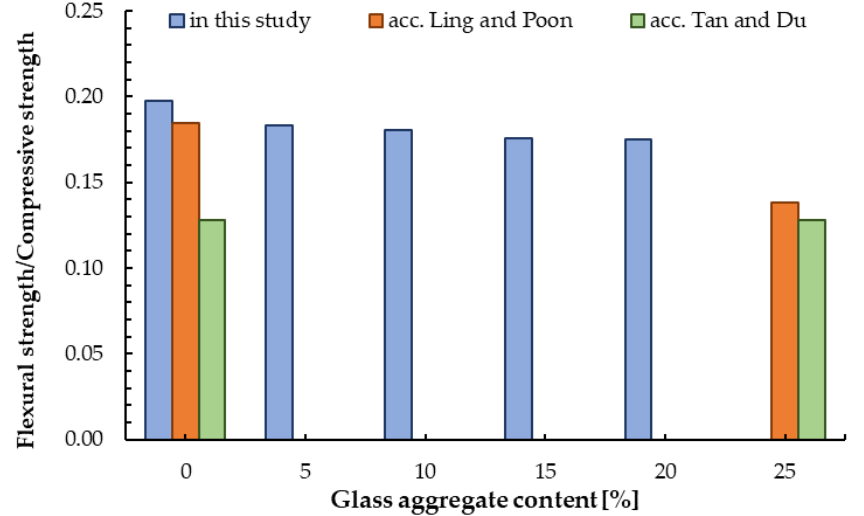
Figure 13. The correlation between compressive and flexural strength for samples with GSA.